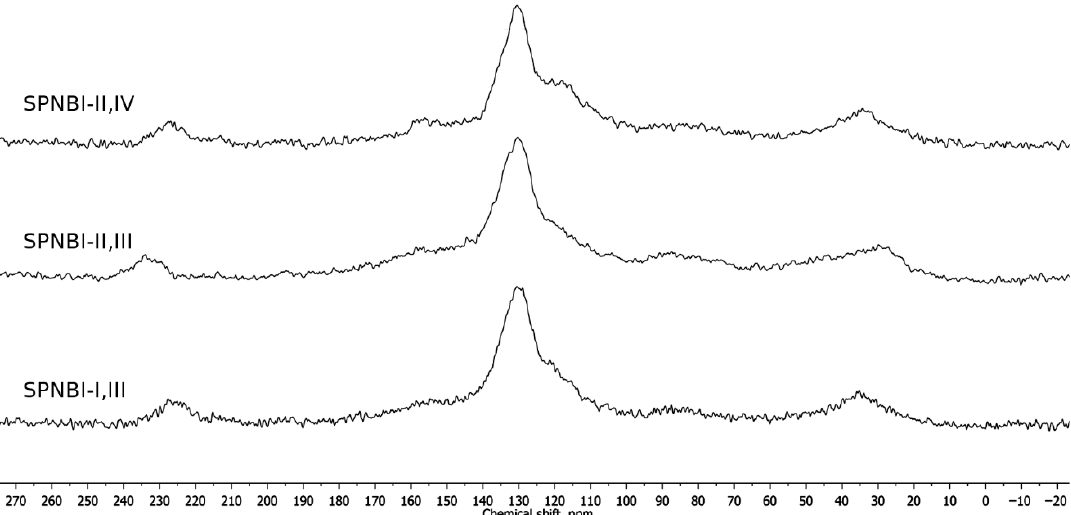
Figure 1. Solid-state 13 C NMR spectra for synthesized polymers.